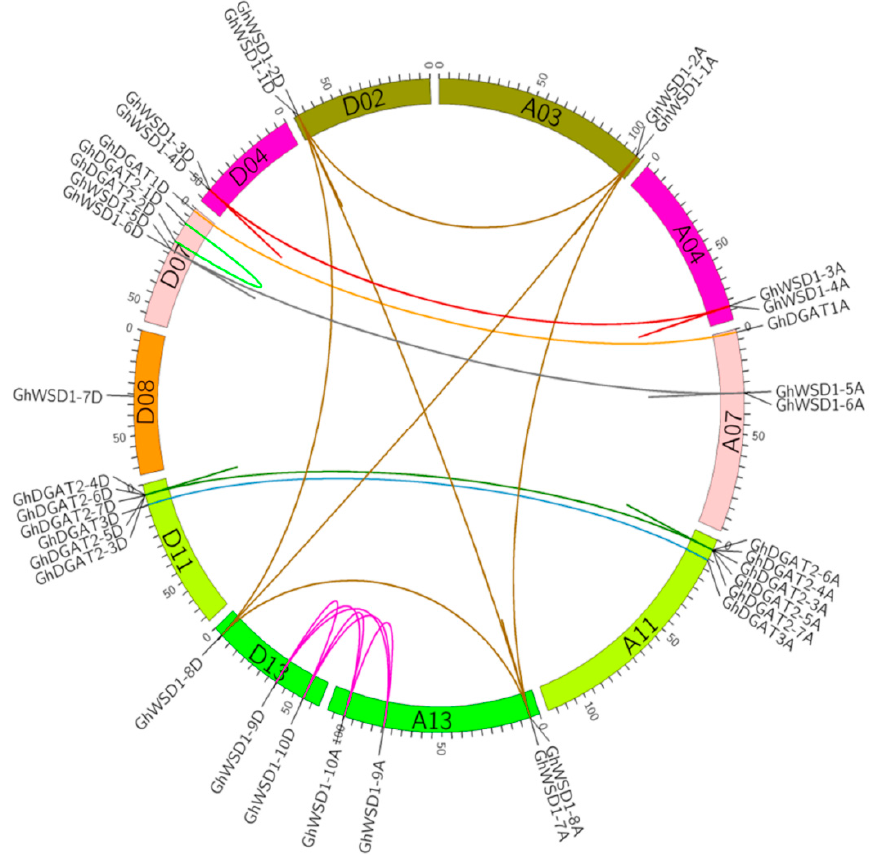
Figure 2. The synteny relationship of GhDGAT and GhWSD1 genes. The relationship was visualized using Circos software. The homologous and homoeologous chromosomes in At and Dt subgenomes are displayed in the same color. The synteny relationship of GhDGAT and GhWSD1 genes are detectable in different colors. Light green lines: paralog genes of GhDGAT2-1D and GhDGAT2-2D ; bottle green lines: duplicate genes of GhDGAT2 ; blue lines: paralog genes of GhDGAT3 ; dark brown lines: ortholog or paralog genes of GhWSD1-1 , GhWSD1-2 , GhWSD1-8 , and GhWSD1-7A ; red lines: ortholog or paralog genes of GhWSD1-3 and GhWSD1-4 ; orange lines: paralog genes of GhDGAT1 ; pink lines: ortholog or paralog genes of GhWSD1-9 and GhWSD1-10 ; grey lines: ortholog or paralog genes of GhWSD1-5 and GhWSD1-6